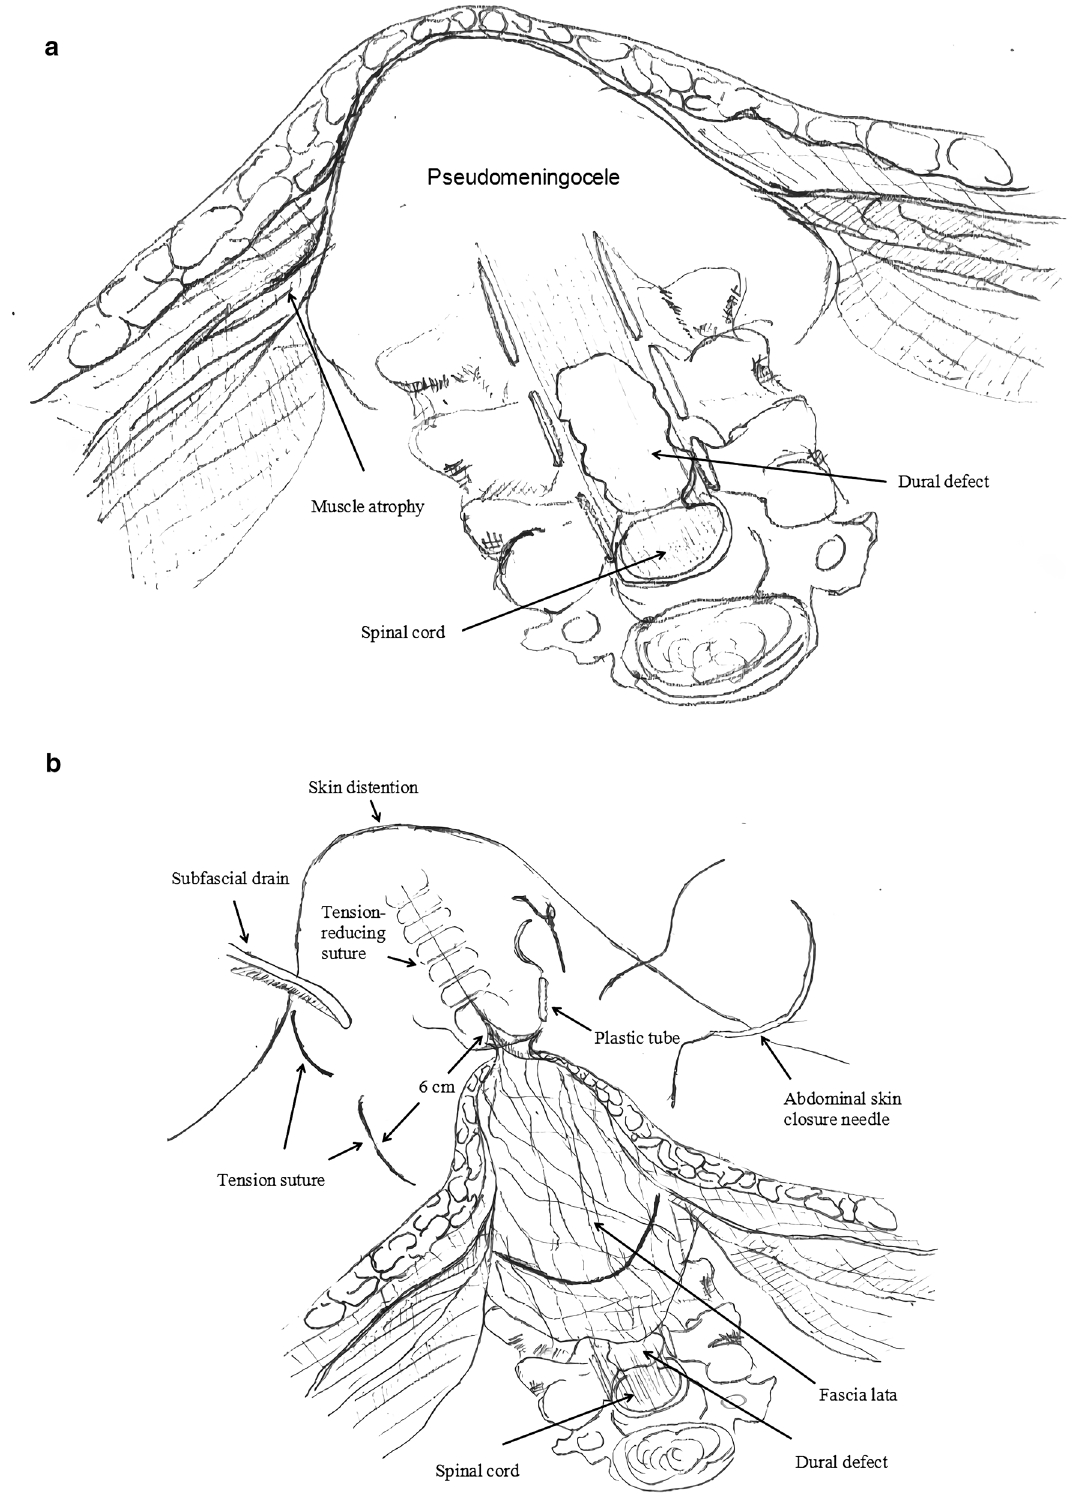
Figure 3. Operation diagram. ( a ) Formation of the pseudomeningocele. ( b ) Fascia lata was packed into the pseudomeningocele cavity and fixed by a compression suture. Then, the cervical posterior soft tissues were compressed and evaluated. ( c ) Post operative photograph of tension reducing